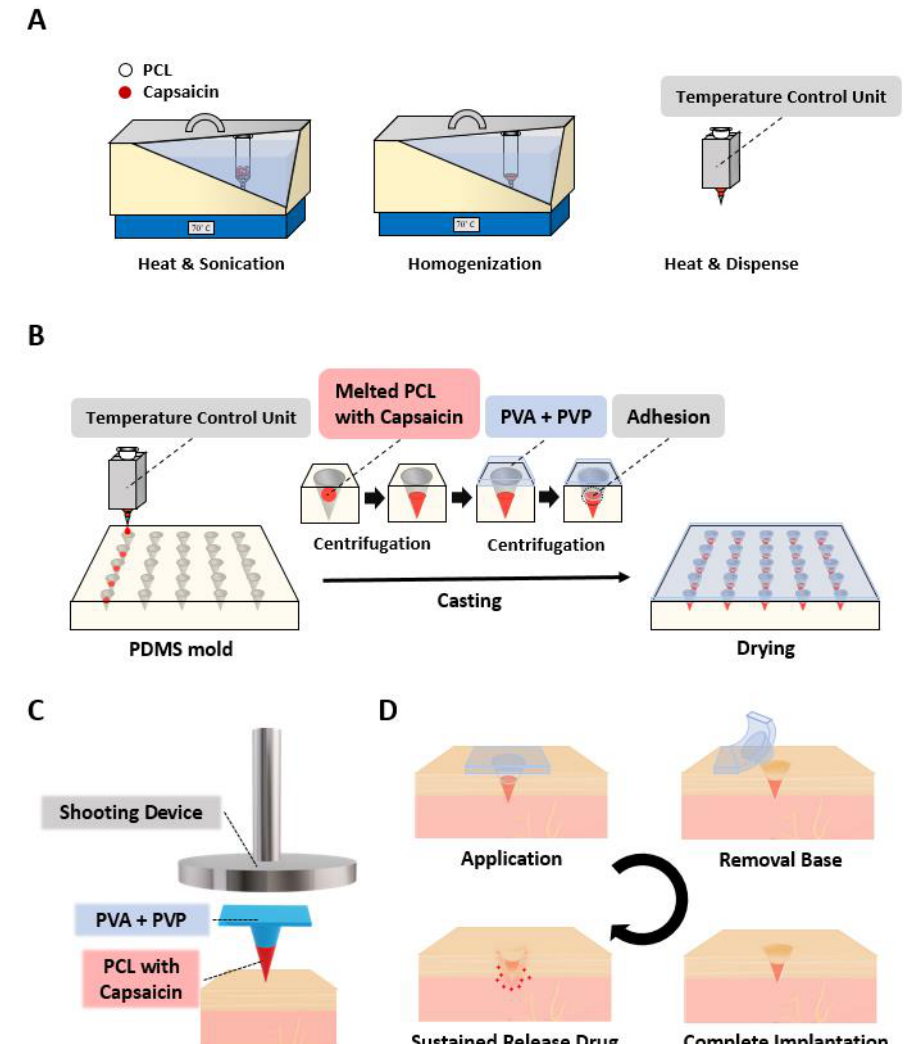
Figure 1. Schematic representation of fabrication of separable polycaprolactone (PCL) dissolving mi- croneedles (SPCL-DMNs) encapsulating capsaicin. ( A ) PCL and capsaicin were drawn into a syringe and homogenized in a sonicator at 65 ◦ C for 24 h; the temperature was controlled by a temperature control unit. ( B ) PCL and capsaicin mixtures were dispensed on the polydimethylsiloxane (PDMS) mold by a robotic dispenser at 65 ◦ C. On the polydimethylsiloxane (PDMS) mold, melted PCL with capsaicin was placed and centrifuged to fill each microneedle-shaped cavity; next, polyvinyl alcohol (PVA) and polyvinylpyrrolidone (PVP) were cast and centrifuged to fill the remaining space in the mold with PCL. After drying, the SPCL-DMNs were peeled off from the mold. ( C ) After detachment of SPCL-DMNs from the mold, they were used directly for implantation into the skin. The SPCL- DMNs were then shot into the skin with the shooting device in the indicated alignment as illustrated in the figure. ( D ) Upon insertion, the base was manually removed for complete implantation, and the implanted PCL was degraded by interstitial fluid in the